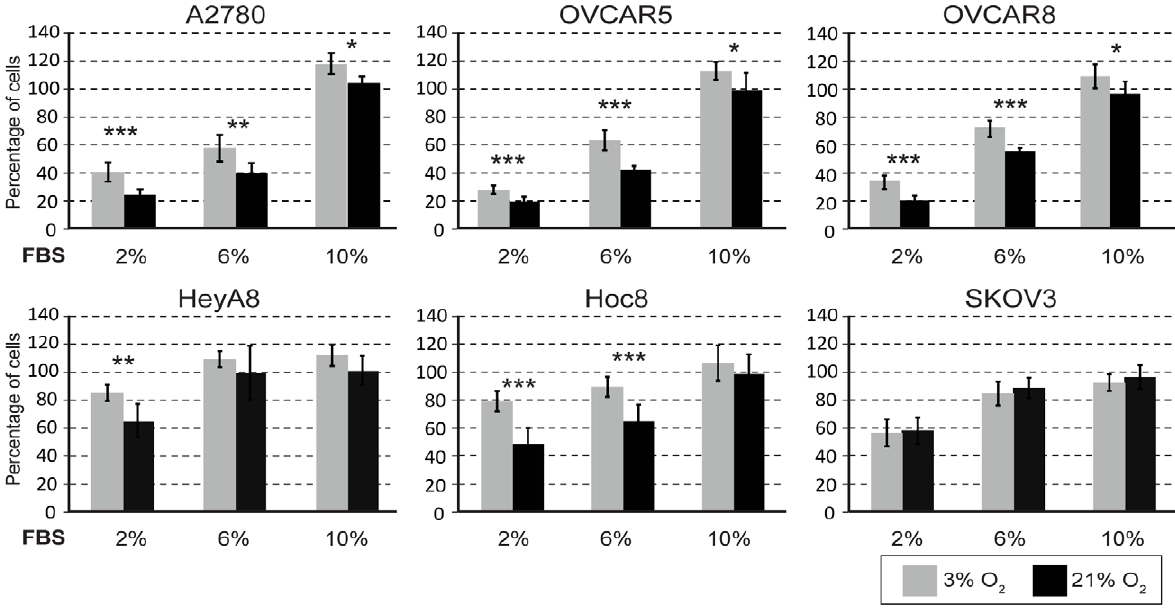
Figure 2. Ovarian cancer cells grown under physiological and ambient O 2 show differential proliferation response. Ovarian cancer cell lines were cultured under 3% or 21% O 2 and the extent of proliferation was determined following 3 days of growth (see Materials and Methods section). For each cell line, the percent of cell proliferation at 3% O 2 (light shaded bars) and at different concentrations of serum was compared with proliferation under standard tissue culture conditions consisting of 21% (ambient) O 2 (dark shaded bars) and 10% FBS. The error bars represent the standard deviations of mean and statistical significant (by student T Test) differences in proliferation between 3% and 21% O 2 for each concentration of serum is indicated by an asterisk [(*) p , 0.05, (**) p , 0.001 and (***) p , 0.0001].